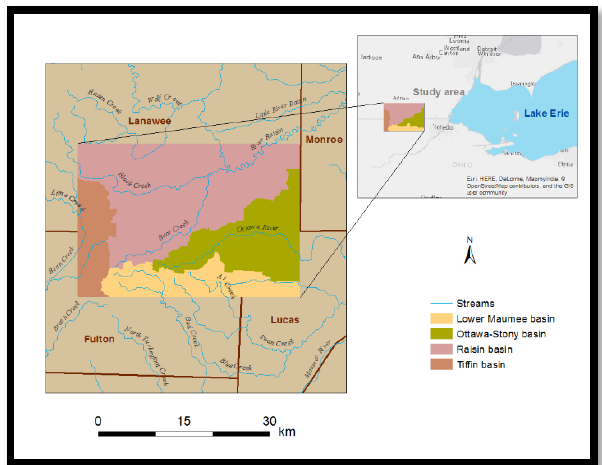
Figure 1: Study site – Agricultural lands in the Western Lake Erie Basin